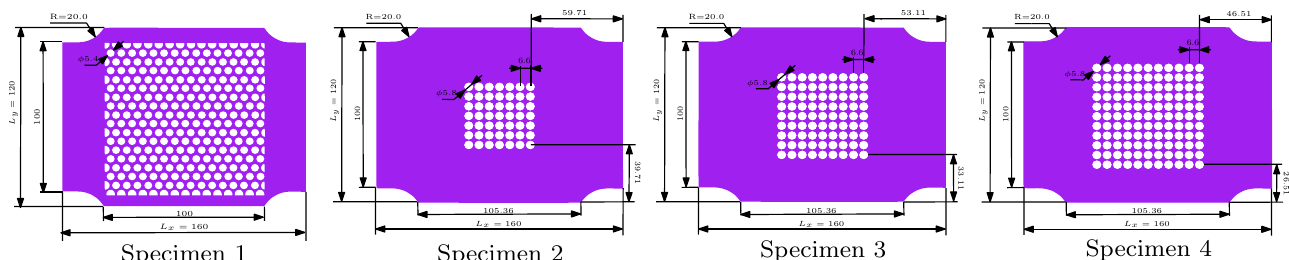
Figure 2. Geometry and dimensions of four specimens used in the present study. Specimen 1 had an oblique lattice of voids, while specimens 2–4 had square lattices of voids. The void diameter and spacing were the same for these specimens